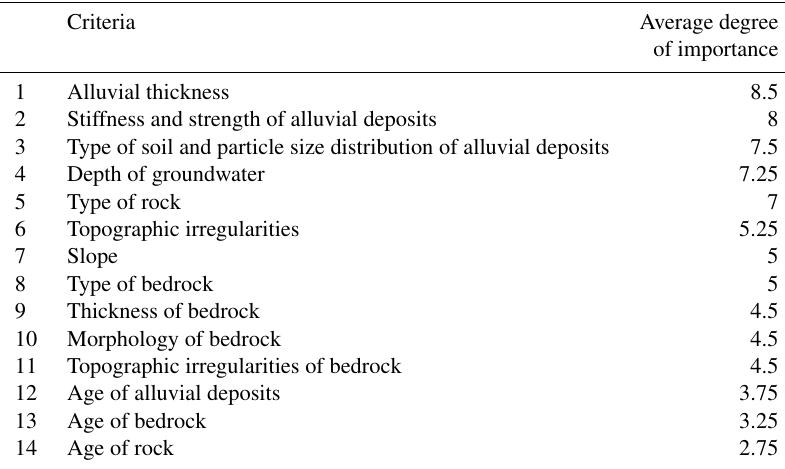
Table 2. The average importance criteria based on the five-point Likert